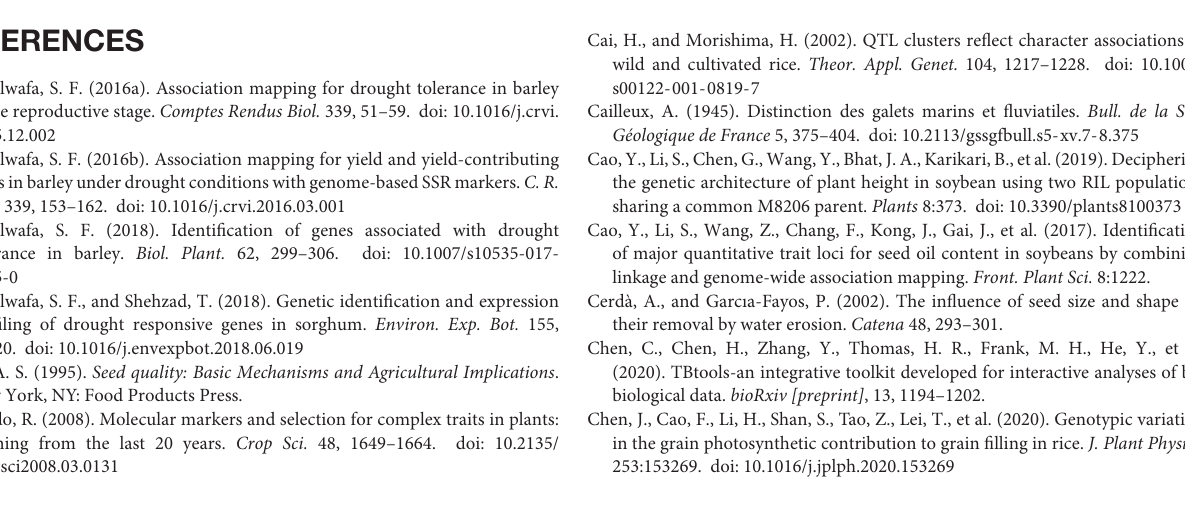
Supplementary Table 12 | Predicted candidate genes within Cluster-03, Cluster-04.1, Cluster-05.1, Cluster-07, Cluster-09, Cluster-17.1, and Cluster-19.1 regions in both RIL Populations (LM6 and ZM6) based on known functional annotation (highlighted lines show candidate genes). Supplementary Table 13 | Candidate genes within seven QTL clusters and their relative expression data retrieved from RNA-seq data available in SoyBase (DAF = days after flowering) (highlighted lines show candidate